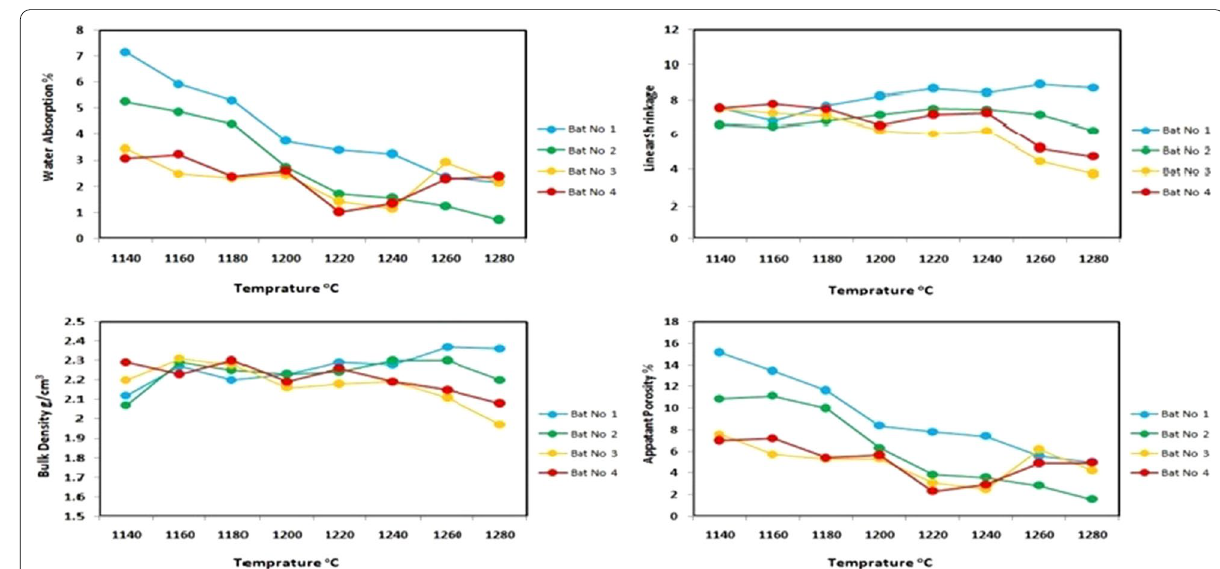
Fig. 6 Densification parameters of the fired